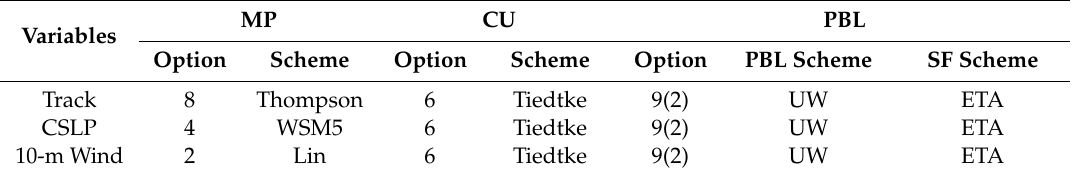
Table 4. Optimal scheme combinations for the simulations of track, CSLP, and 10-m wind.